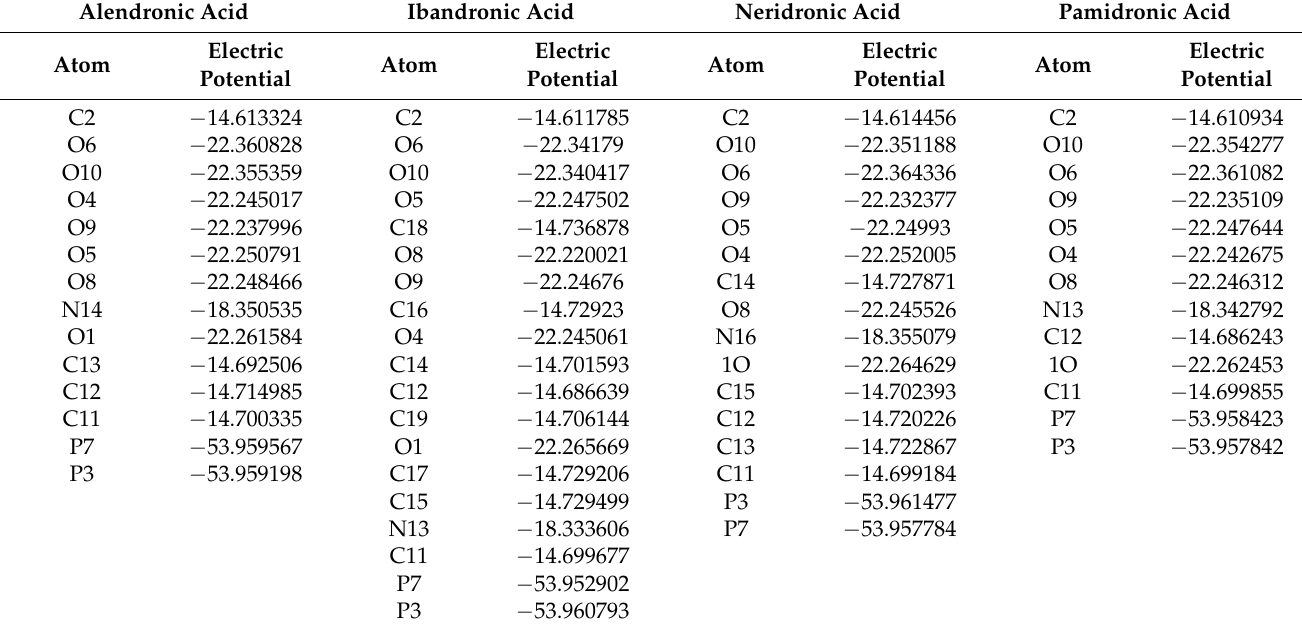
Table 1. Electric potential of some atoms resulting from 14 N-NQR spectra for alendronic acid, ibandronic acid, neridronic acid, and pamidronic acid using B3LYP/6-311+G (d,p) level.